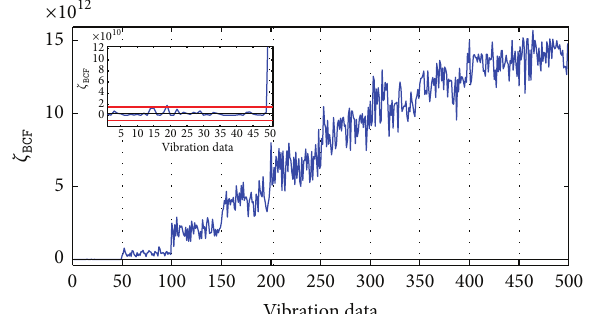
Figure 4: Evolution of the subspace-based damage indicator.